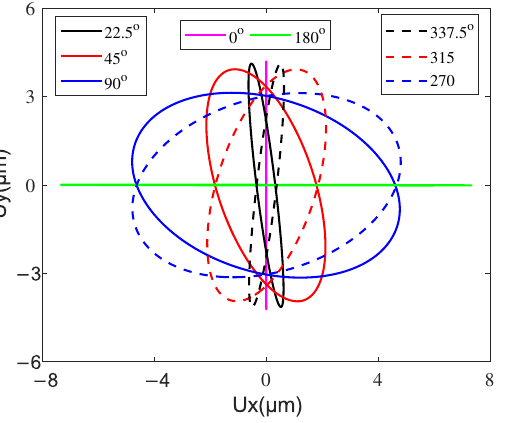
Figure 32. Velocity of the mover versus the phase difference between two excitation voltages.